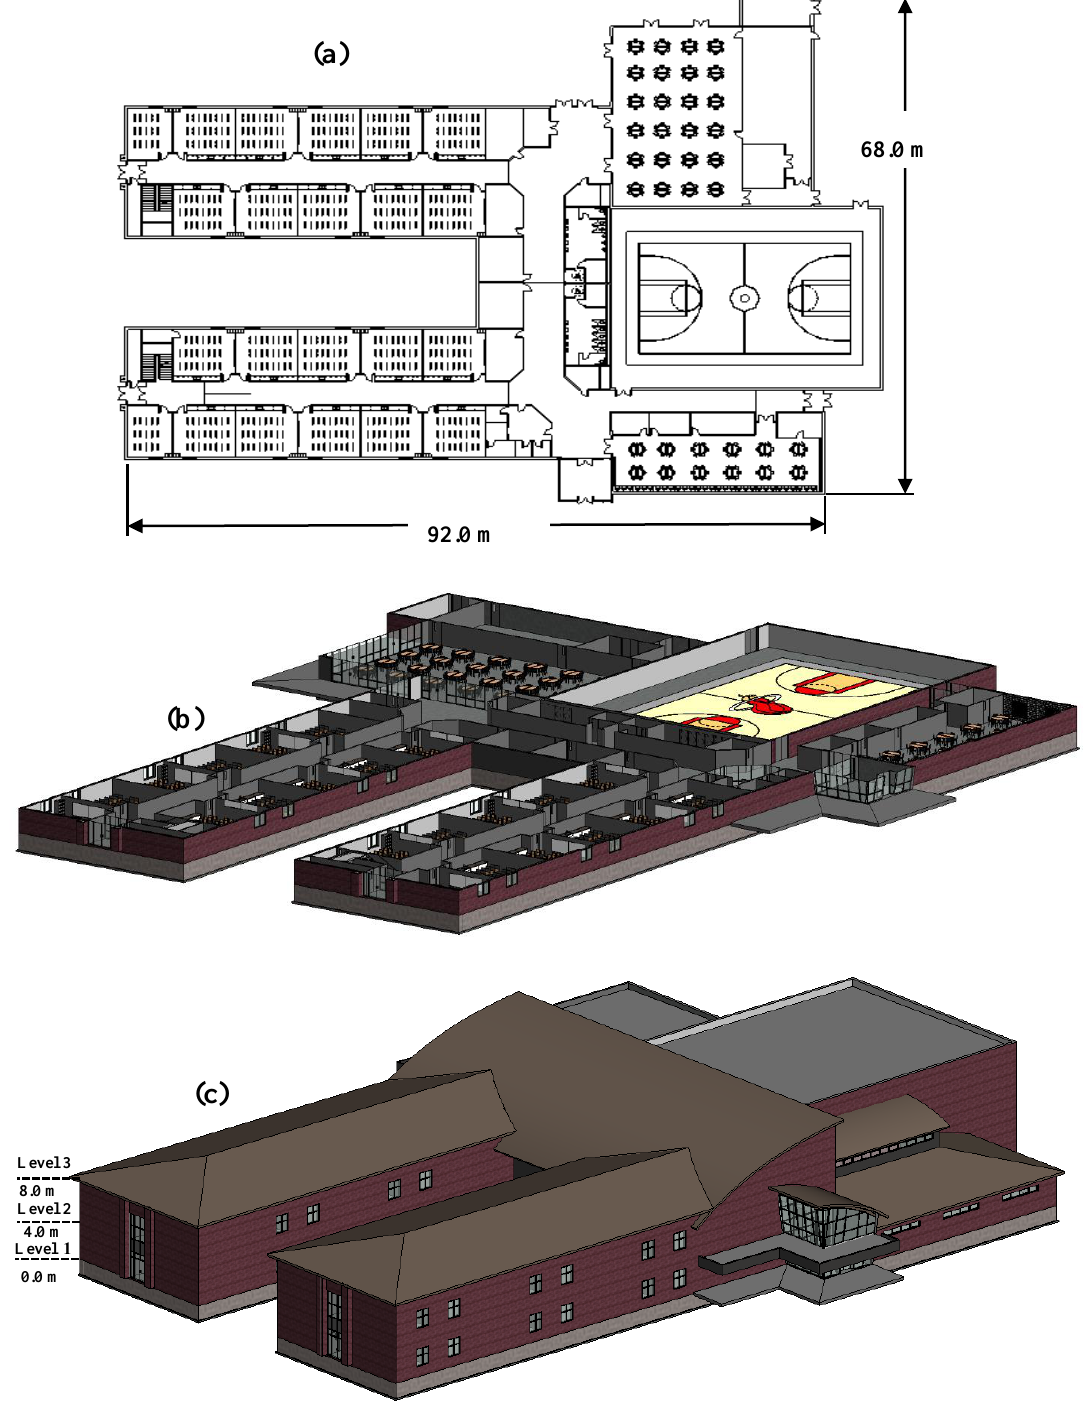
Figure A10. F11 archetype plans and sections: ( a ) Plan view; ( b ) 3-D view for the interior of the school; ( c ) 3-D view for the whole school.